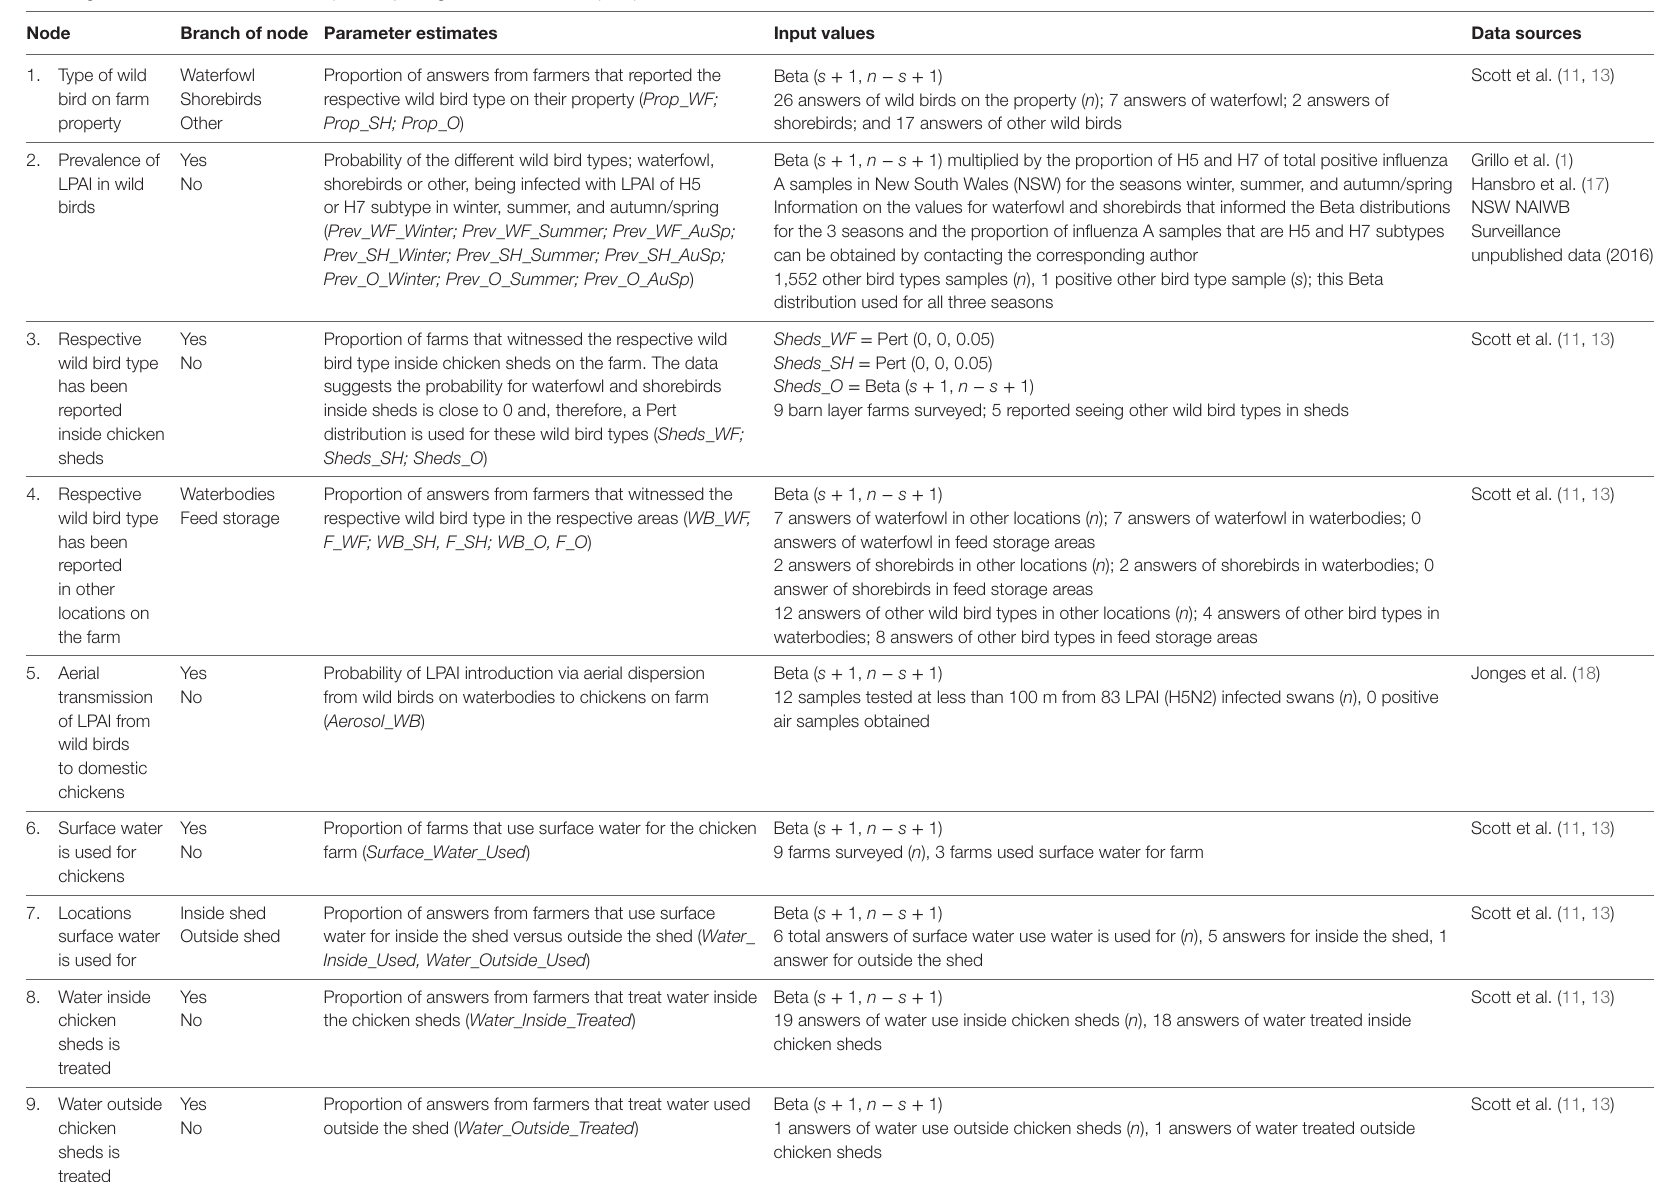
TaBle 4 | Nodes, parameter estimates, and input values used for the exposure assessment estimating the probability of exposure of commercial chickens on barn layer farms in Australia (specifically in the Sydney basin region and South East Queensland) to low pathogenic avian influenza (LPAI) from wild